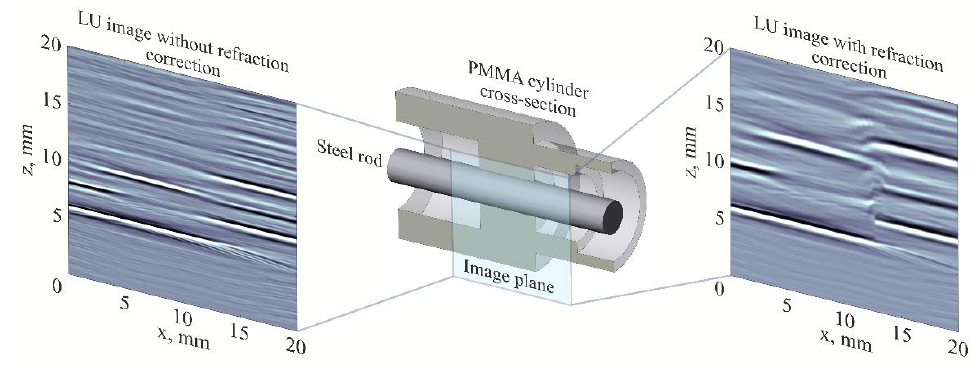
Figure 9. The cross-sectioned 3D model of the sample object: poly (methyl methacrylate) (PMMA) solid of revolution with complex external and internal generatrices fixed on a steel rod and submerged in water ( center ). The reconstructed LU image of the sample object after the first stage of the algorithm without refraction correction ( left ). The final refraction-corrected image ( right ). Black and white stripes show the position of the boundaries that reflect the ultrasonic probe pulse and the sign of the acoustic reflection coefficient (black—negative and white—positive). Adapted with permission from [54], OSA Publishing, 2018.